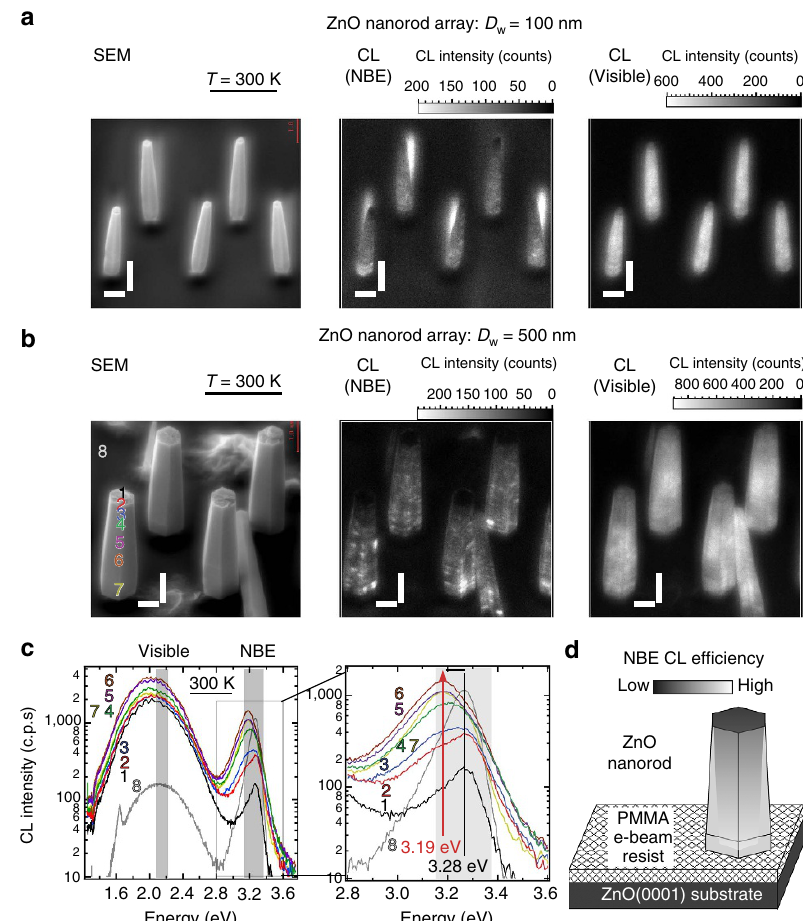
Figure 1 | Bird’s-eye view NBE/Visible CL imaging of ZnO free-standing nanorods. SEM and monochromatic (NBE/Visible) CL images of ZnO free-standing nanorod arrays, probed by 3.0keVe-beam. Each nanorod is homoepitaxially grown from individual growth window with a variety of diameter: ( a ) small diameter growth windows ( D w ¼ 100nm) and ( b ) large diameter growth windows ( D w ¼ 500nm). Nanorods misorientation in D w ¼ 100nm array takes place during the SEM observation due to electrical charge-up. A bright shadow behind each nanorod array in NBE CL image are signal from ZnO substrate, which is excited due to PMMA thinning by the concentrated e-beam dose. ( c ) Spot-CL spectroscopy at positions 1–8 in b , probed by 4.5keV e-beam. Spectral bands for NBE/Visible CL imaging are highlighted with transparent grey zones. ( d ) A schematic of ZnO free-standing nanorod. Local NBE CL emission efficiency within the nanorod is illustrated by grey scale. The specimen is tilted by 45 degree from ZnO (0001) plane normal. All horizontal and vertical scale bars indicate lengths of 0.5 m m and 1.0 m m, Figs 3 and 4. Note that each nanorod exhibits some locally bright NBE CL emission spots (CL spots) on m side-planes. As spectrum 6 on a CL spot shows the same spectral shape as those at other spot positions on m plane, the CL spots have the same properties of m plane.